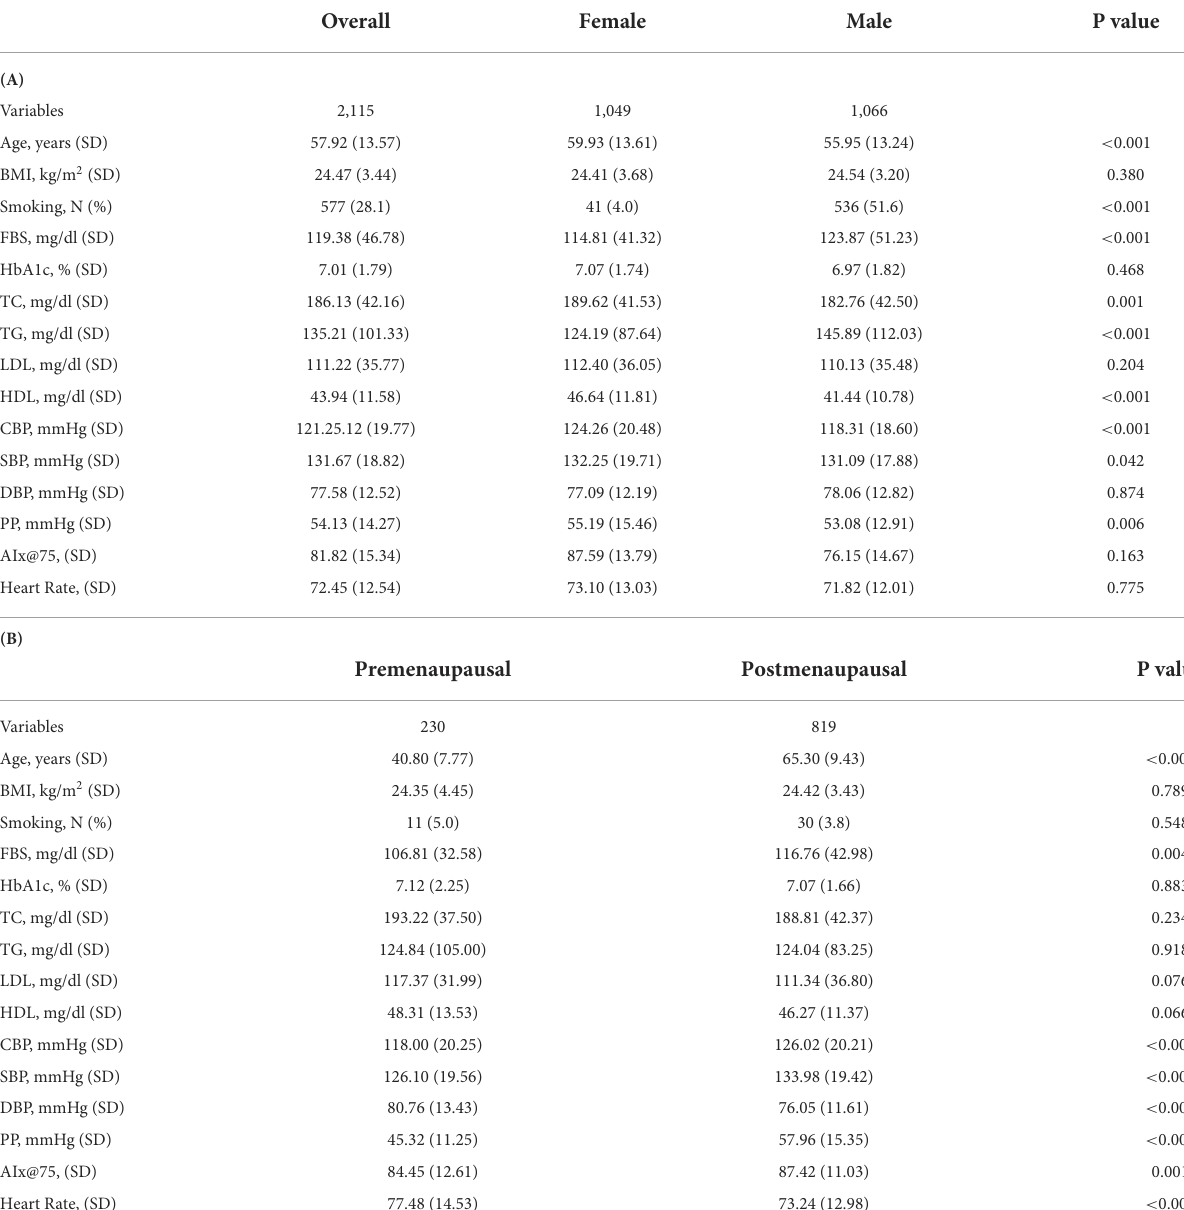
TABLE 1 (A) Baseline characteristics of the participants. (B) Baseline characteristics of the participants divided by menopause. Overall Female Male P